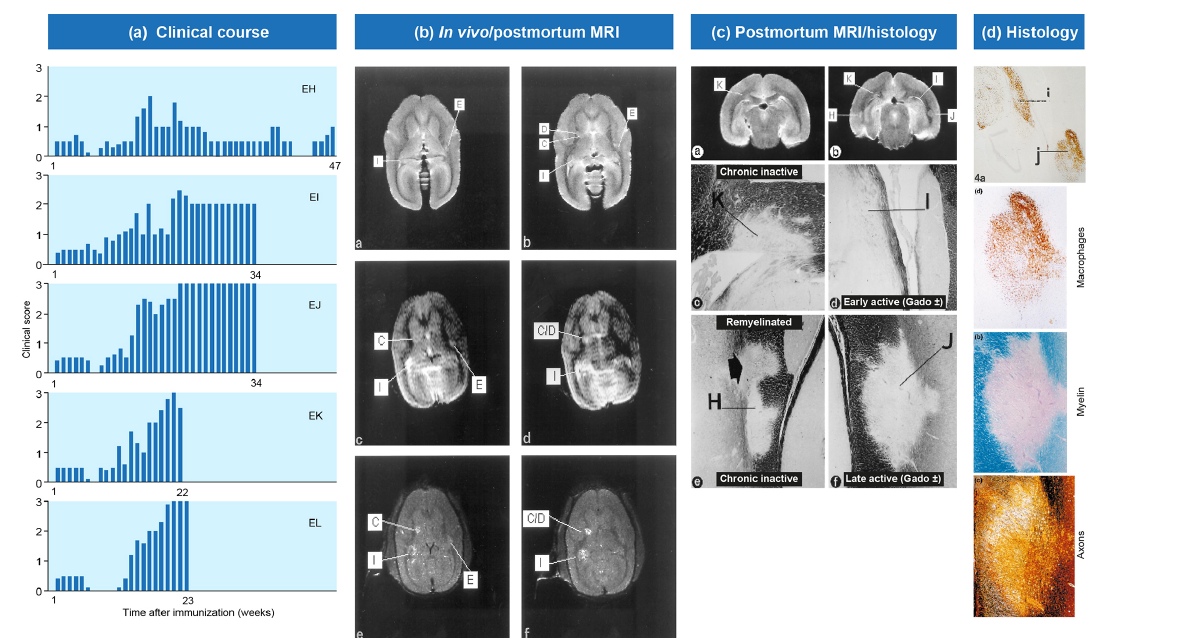
Figure 2. Clinical and pathological aspects of marmoset EAE induced with MS myelin/CFA. (a) The graphs show the protracted clinical course, which is variable among individual animals. Case EH has relapsing–remitting disease that could be followed for almost 1 year. The other four cases transit to progressive disease, which can worsen quickly (EK, EL) or more slowly (EI, EJ). (b) Case EI was subjected to in vivo magnetic resonance imaging (MRI) just before sacrifice. The middle and bottom rows show two horizontal brain slices from a T2-weighted image (middle) and a postcontrast (triple dose Gadolinium-DTPA; bottom) with the position of corresponding lesions indicated. After the scans were made, the monkey was humanely killed, the brain was removed and fixated in toto. Then a new postmortem T2-weighted scan was made. This allowed us to determine the exact position of all lesions that were detected in vivo. (c) The top row shows two coronal sections of the same MRI scan with lesions indicated. The middle and bottom rows show a magnification of individual lesions, which allowed us to conclude that brain lesions in this model are presented in different stages. (d) The top image shows an MRP14 staining of macrophages from lesions I and J, illustrating their inflammatory active nature. Notice that lesion I is one of the two gadolinium contrast-enhancing lesions. The three images below show the histological aspect of lesion J, which is characterized by primary demyelination (LFB staining), sparing of axons (Bielschowsky silver impregnation) and inflammation (MRP14). The macrophage staining shows the heterogeneity of this